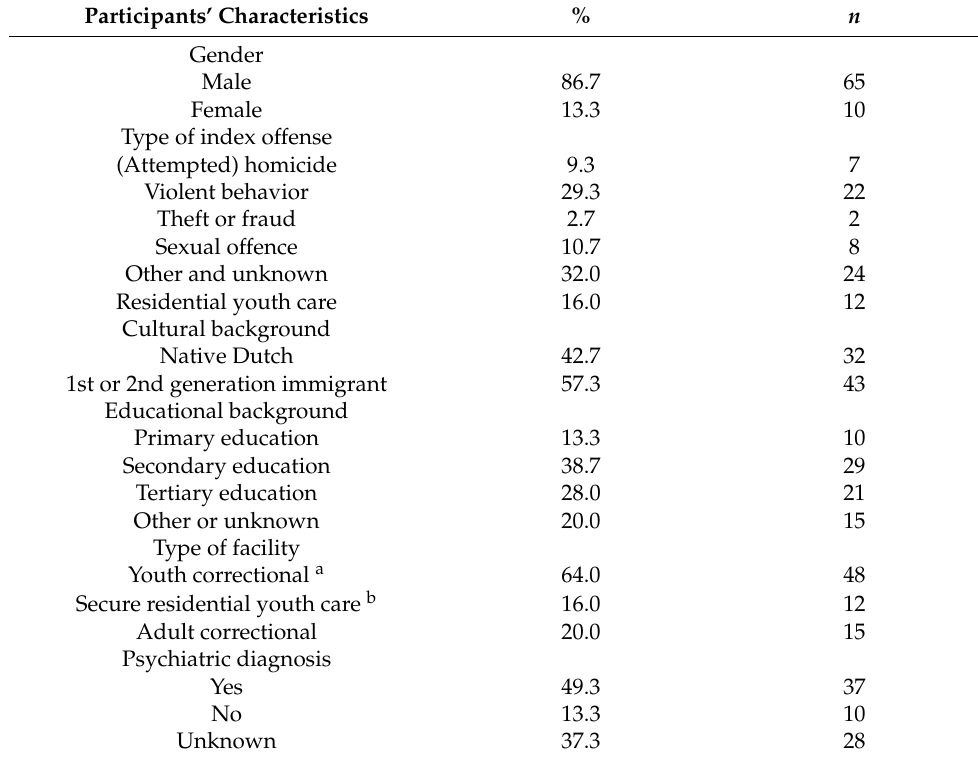
Table 1. Descriptive Statistics for the Final Sample ( n =